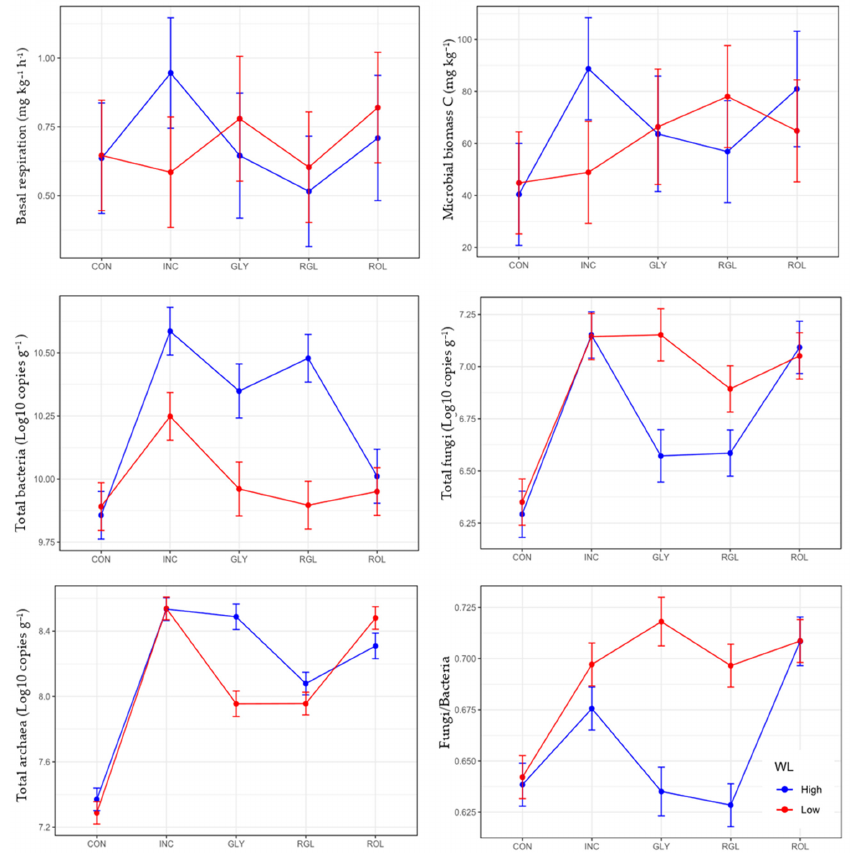
Figure 2. Basal respiration, microbial biomass carbon, total bacteria, total fungi, and F/B ratio at 57 DAS maize for the termination methods: control (CON), mowing + incorporation (INC), glyphosate (GLY), glyphosate + roller (RGL), and roller crimper (ROL), under two water levels. Bars represent 95% confidence intervals according to Tukey’s HSD